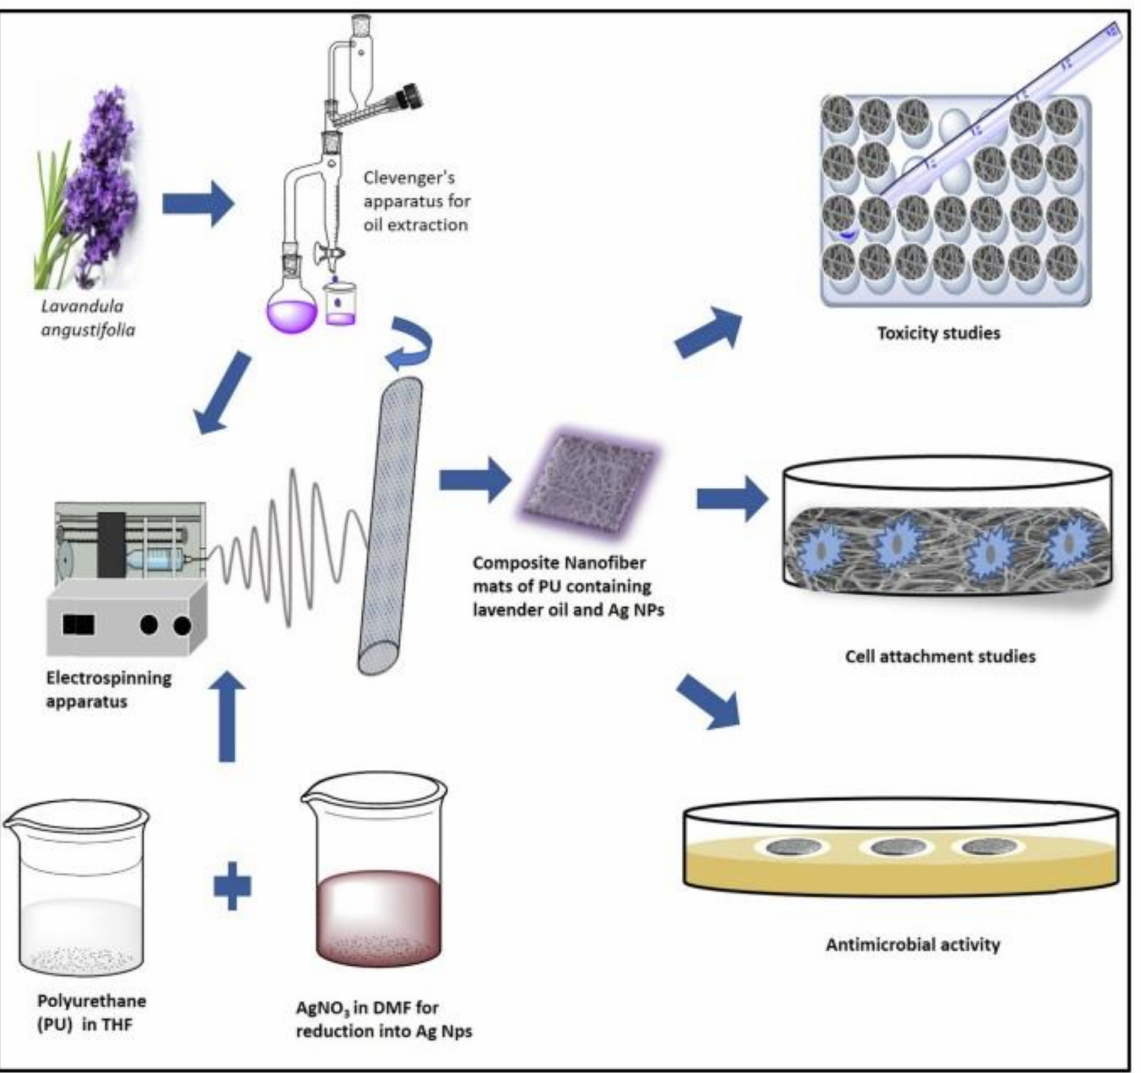
Figure 5. Scheme illustrating the nanofiber composites fabrication through electrospinning, from polyurethane encasing lavender oil and Ag nanoparticles. Reprinted with permission from ref. [146]. Copyright 2019, Elsevier